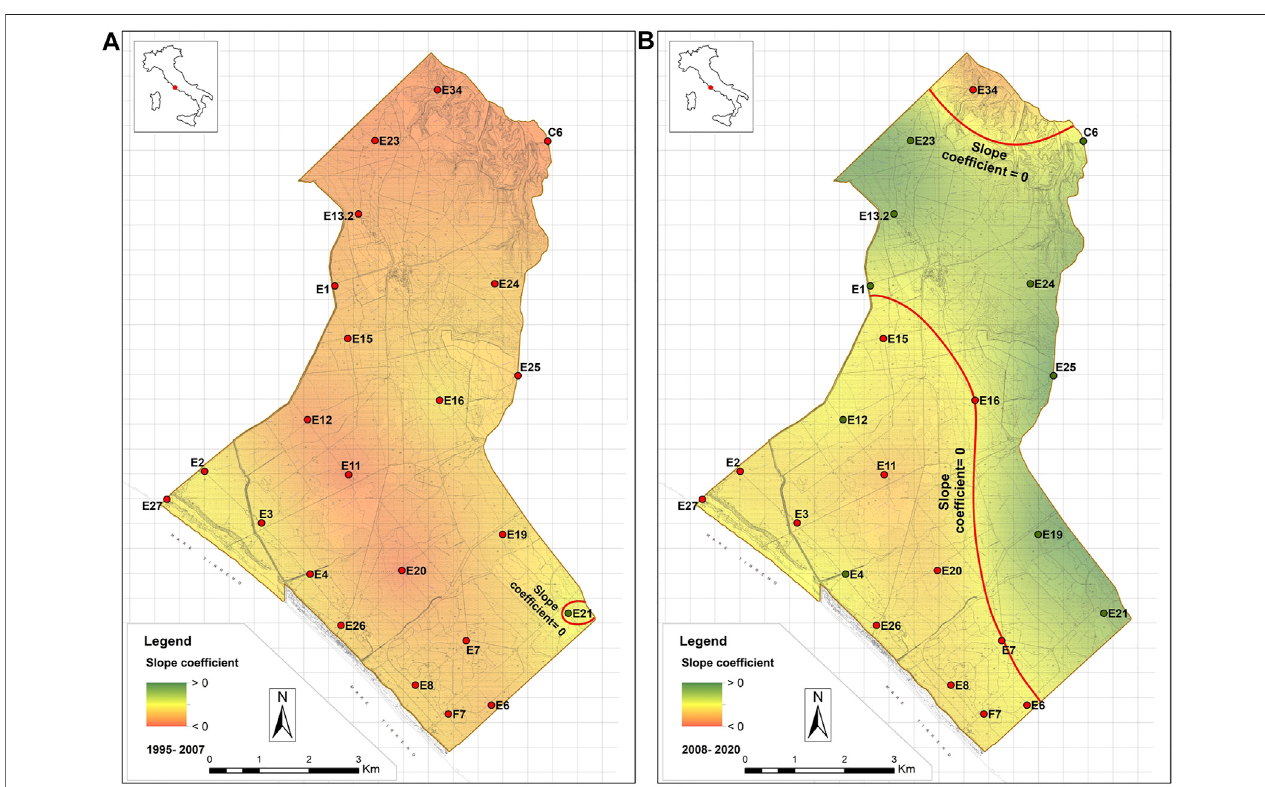
FIGURE 10 | Slope coef fi cient distribution maps of water level trend calculated for the 1995 – 2007 monitoring period (A) and 2008 – 2020 (B) .